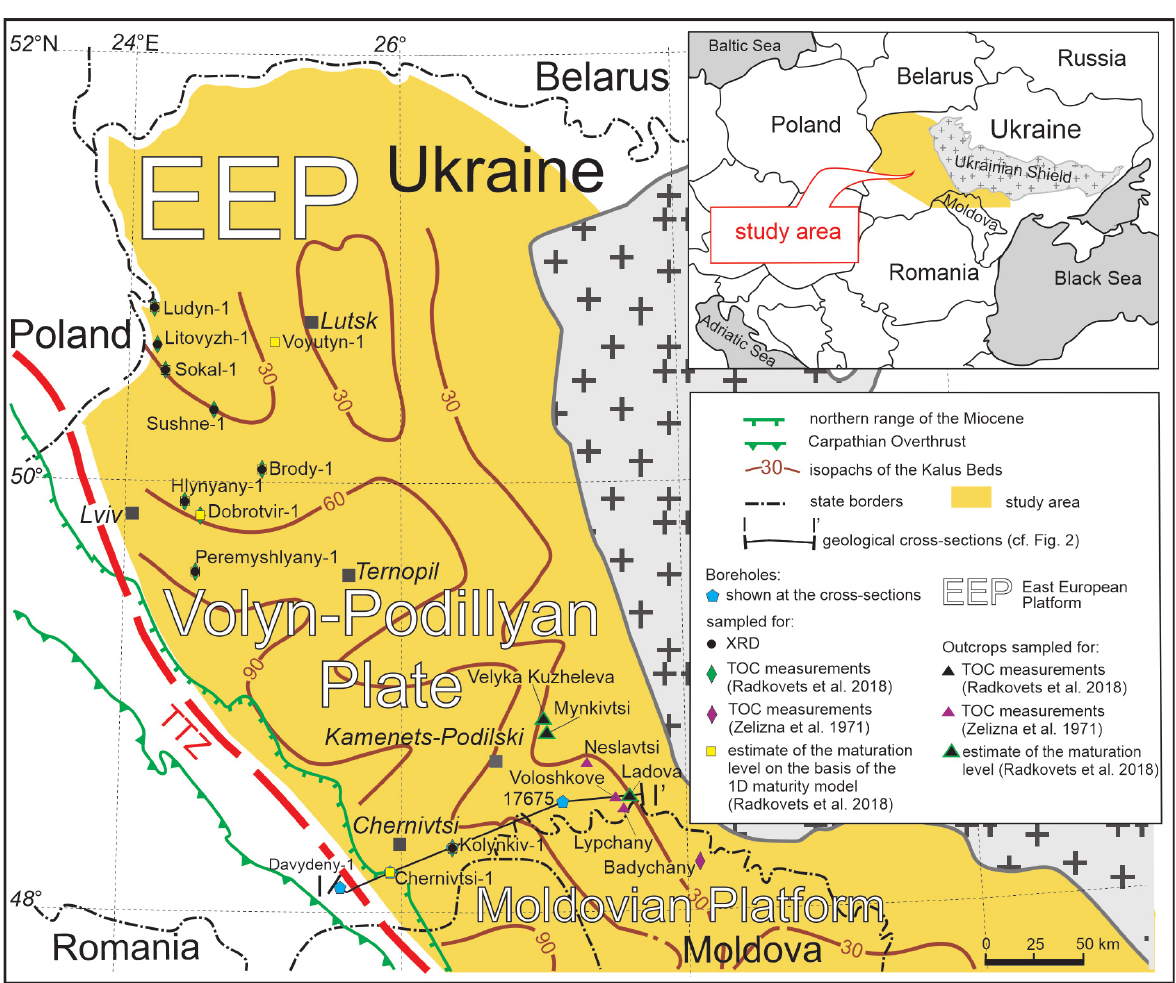
Fig. 1. Location map, showing the distribution and thickness of the organic-rich Ediacaran Kalus Beds within western Ukraine and NW Moldova and the studied boreholes. TTZ, Teysseyre-Tornquist Zone (modified after Radkovets et al.